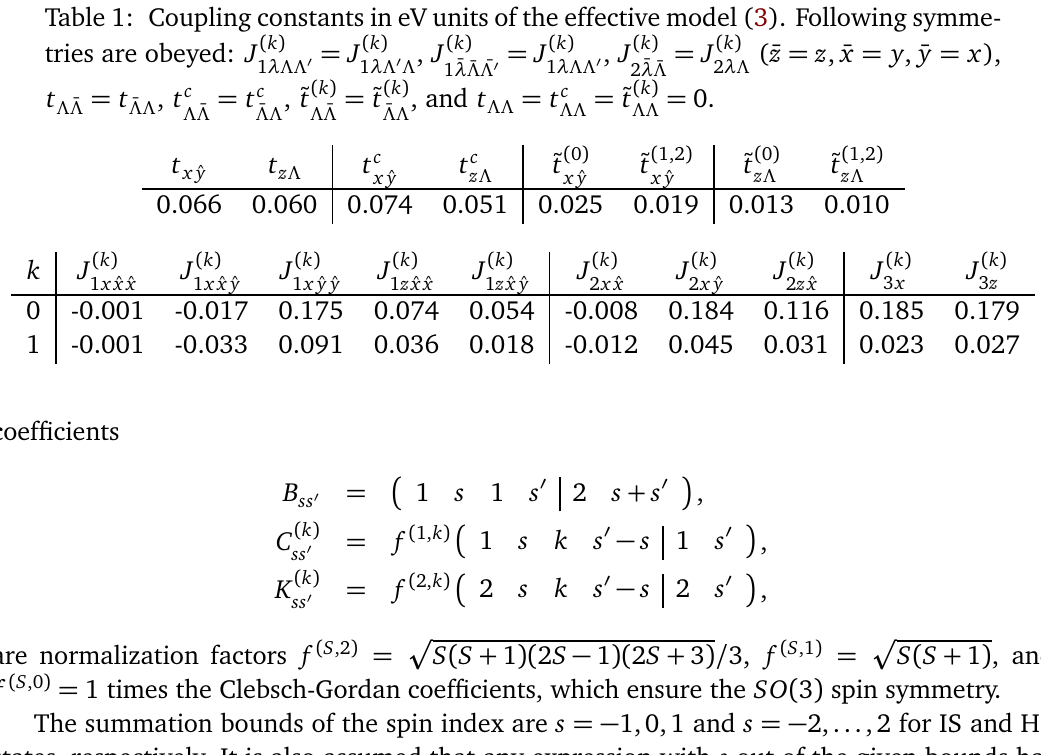
Table 1: Coupling constants in eV units of the effective model (3). Following symme- tries are obeyed: J